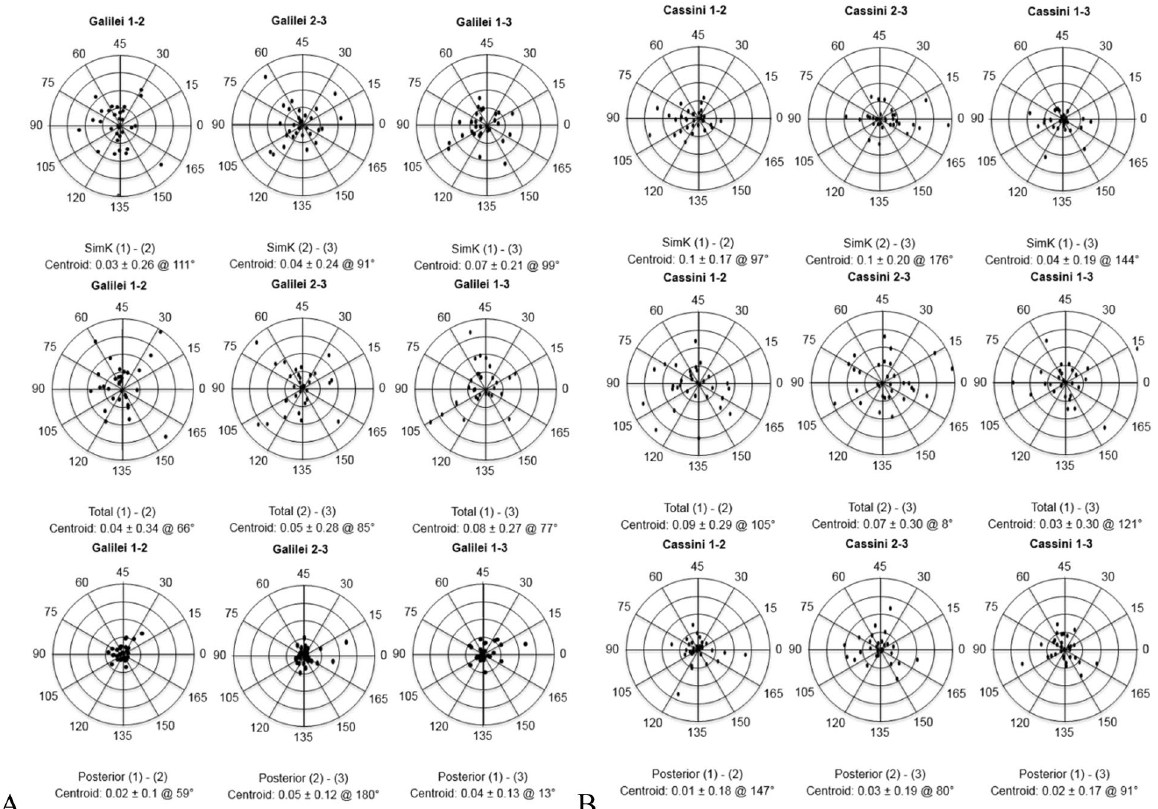
Figure 1. ( A ) Galilei and ( B ) Cassini, for normal eyes, double-angle plots showing intrasubject differences in simulated keratometric (SimK) (top row), total (middle row), and posterior corneal astigmatism (bottom row) measurements. Each ring represents 0.25 diopters (D), and the outer ring represents 1.0 For the all corneal power Cassini measurements in normal eyes, the CoV was ≤ 0.85% and the Sw was ≤ 0.17 D; for all corneal astigmatism measurements with the Cassini, the CoV was ≤ 32.22% and the Sw was ≤ 0.19 D. The ICCs were > 0.9 for all corneal power and astigmatism magnitudes, with the exception of posterior corneal astigmatism, which was 0.554. In post refractive eyes, the Sw was ≤ 0.22 D and the CoV was ≤ 0.45% for all corneal power measurements with the Galilei; the Sw was ≤ 0.24 D and the CoV was ≤ 25.34% for all corneal astigmatism measurements with the Galilei. The ICCs were > 0.9 for all corneal power and astigmatism magnitudes, except for posterior corneal astigmatism, which was 0.669. For all corneal power measurements with the Cassini in post-refractive eyes with the Cassini, the Sw was ≤ 0.24. The CoV was 0.35%, 0.39%, 1.19% for simK, total, and posterior corneal power measurements. For all corneal astigmatism measurements with the Cassini, the Sw was ≤ 0.27 D and the CoV was ≤ 30.98%. Although the ICC for posterior corneal astigmatism which was 0.380, the ICCs were > 0.9 for all other corneal power and astigmatism magnitudes. There was a statistically significant difference between the means from the Cassini and Galilei G4 devices (p < 0.01) for total corneal power in normal eyes and for posterior corneal power in post-refractive eyes. In normal eyes, the intrasubject differences in astigmatism between repeated measurements were within 0.75 D except for one simK plot under Galilei analysis, two of the simK plots under Cassini analysis as well as all posterior corneal astigmatism double angle plots in both the Cassini and Galilei (Fig. 1) 16 . Most total corneal astigmatism measurements in normal eyes were within 1.0 D, except for one plot under Cassini analysis with outliers > 1.0 D. In post-refractive surgery eyes, the differences in astigmatism magnitude were within 1.0 D for all measure- ments, except for one plot measuring simK astigmatism under Galilei analysis and one pair of plots measuring total corneal astigmatism each in the Cassini and Galilei groups with outliers > 1.0 D (Fig. 2) 16 . In post-refractive eyes, the 95% LoA between repeated measurements for posterior and total corneal power and astigmatism were larger than in normal eyes. In normal eyes, the 95% LoA were smaller in posterior corneal astigmatism and power than for total corneal astigmatism and power, as well as in post-refractive eyes (Figs. 3 and 4) 16 . In both normal and post-refractive eyes, outliers beyond the 95% LOA were seen in all corneal astig- matism and power measurements.